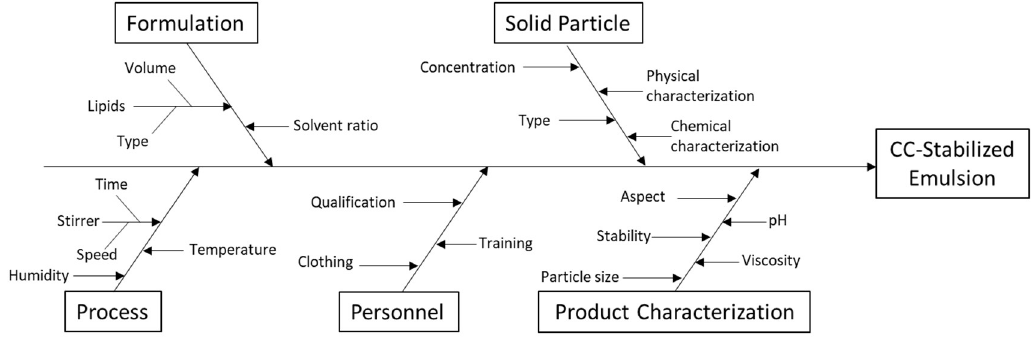
Figure 3. Ishikawa diagram showing factors that may impact the droplet size of a CC-stabilized emulsion [33].